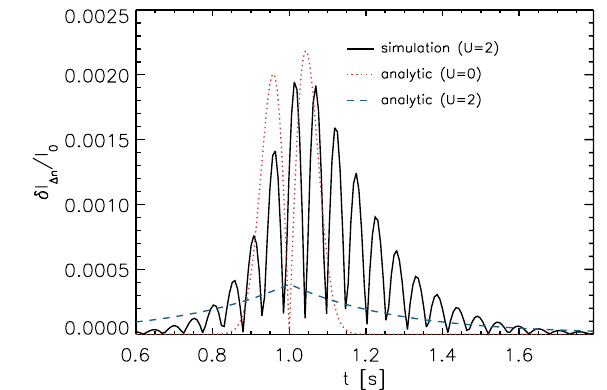
FIG. 4. (Color) Comparison of the echo amplitude versus time obtained from the simulation (solid line), the analytic ballistic echo theory (red dotted line), and from the analytic collective echo theory (blue dashed line) for U (cid:2) 2 and (cid:6) (cid:2) 0 : 1 s .